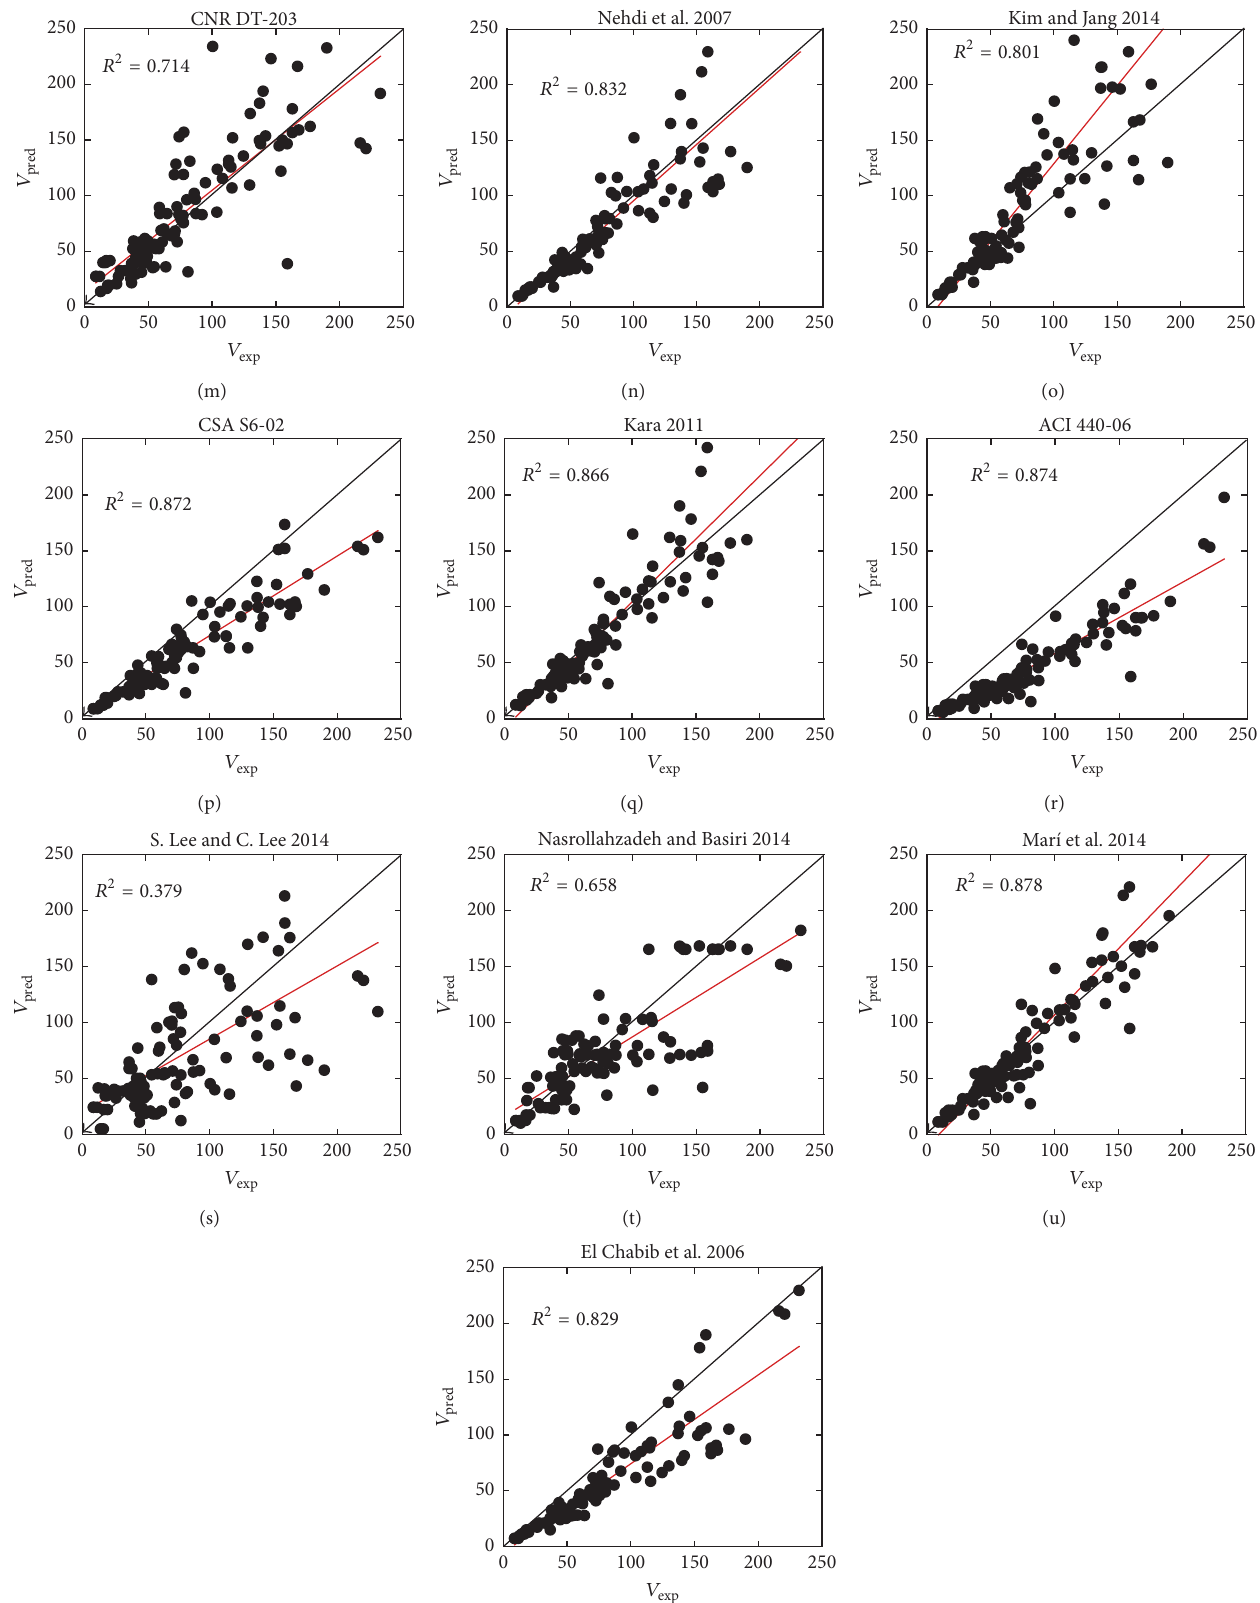
Figure 7: Ratio of predicted and experimental shear